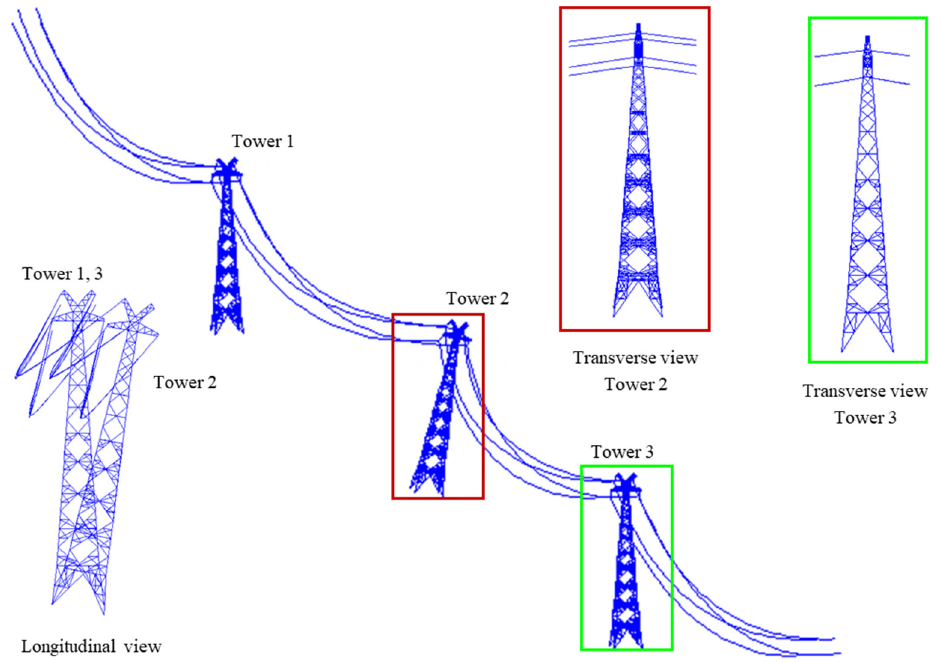
Figure 11. Behavior of the transmission tower-line structure at t = 9 s under Case 1.